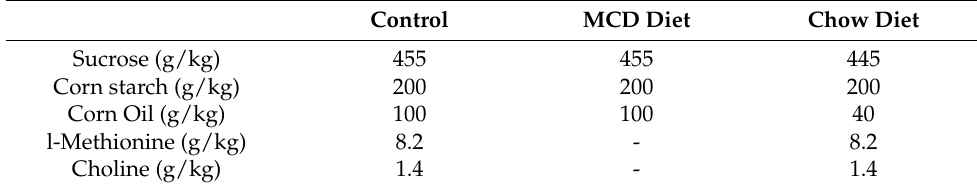
Table 1. Composition of diets.